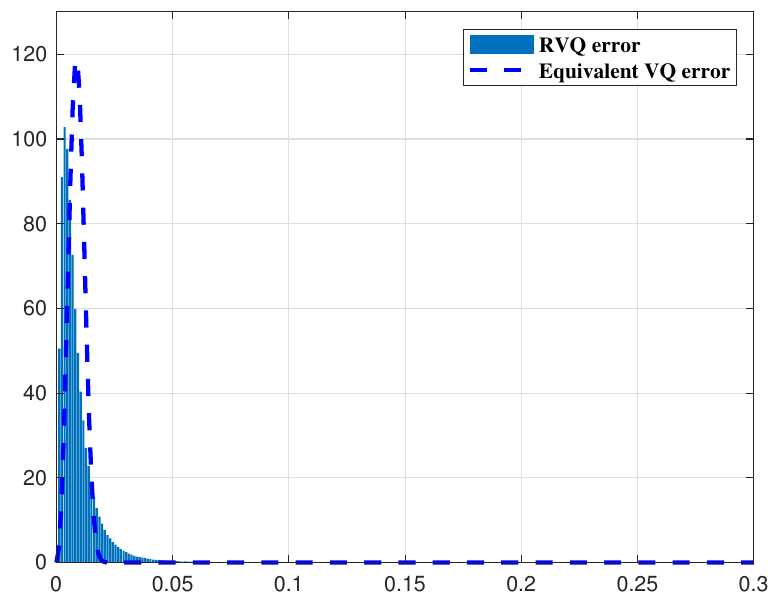
Figure 3. PDFs of RVQ error z and equivalent VQ error ˜ z with B = 20, β =